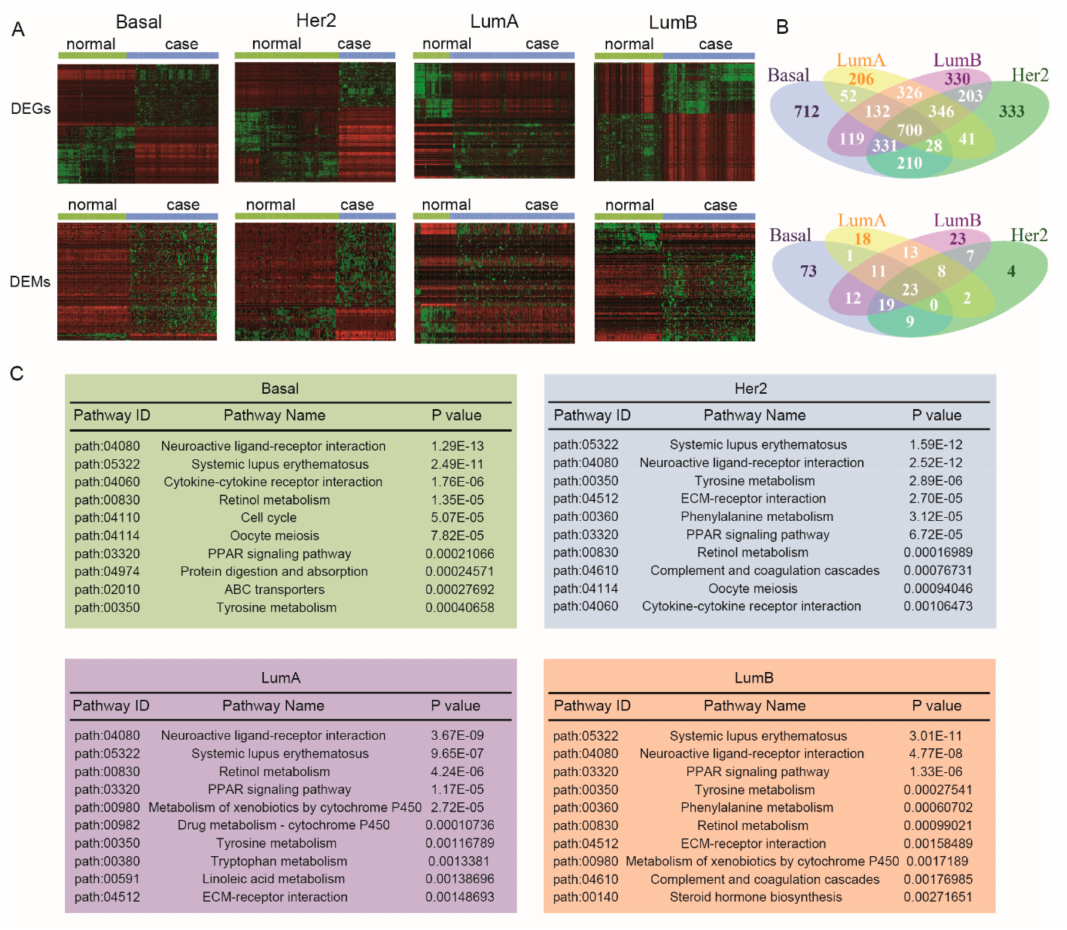
Figure 2. Global view of risk genes and miRNAs in each subtype of breast cancer. ( A ) Heat maps show risk genes and miRNAs in four breast cancer subtypes. Unsupervised hierarchical clustering analysis is used, which divided genes and miRNAs into two clusters, the lower and higher expression values are represented by green and the red colors, respectively. ( B ) Venn plots of risk genes and miRNAs associated with breast cancer subtypes separately. ( C ) Results of top 10 pathways with significant enrichment result of each subtype. Note: Basal, basal-like subtype; Her2, her2-enriched subtype; LumA, luminal A subtype; LumB, luminal B